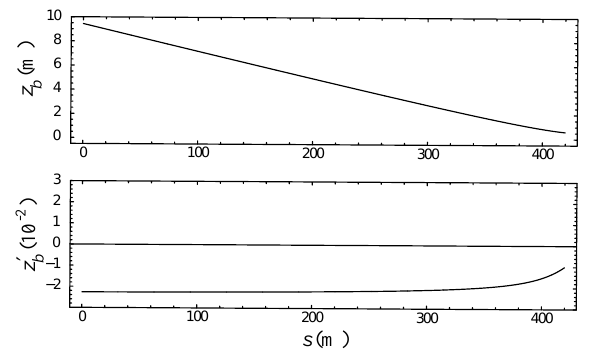
FIG. 3. Longitudinal drift compression of a heavy ion fusion